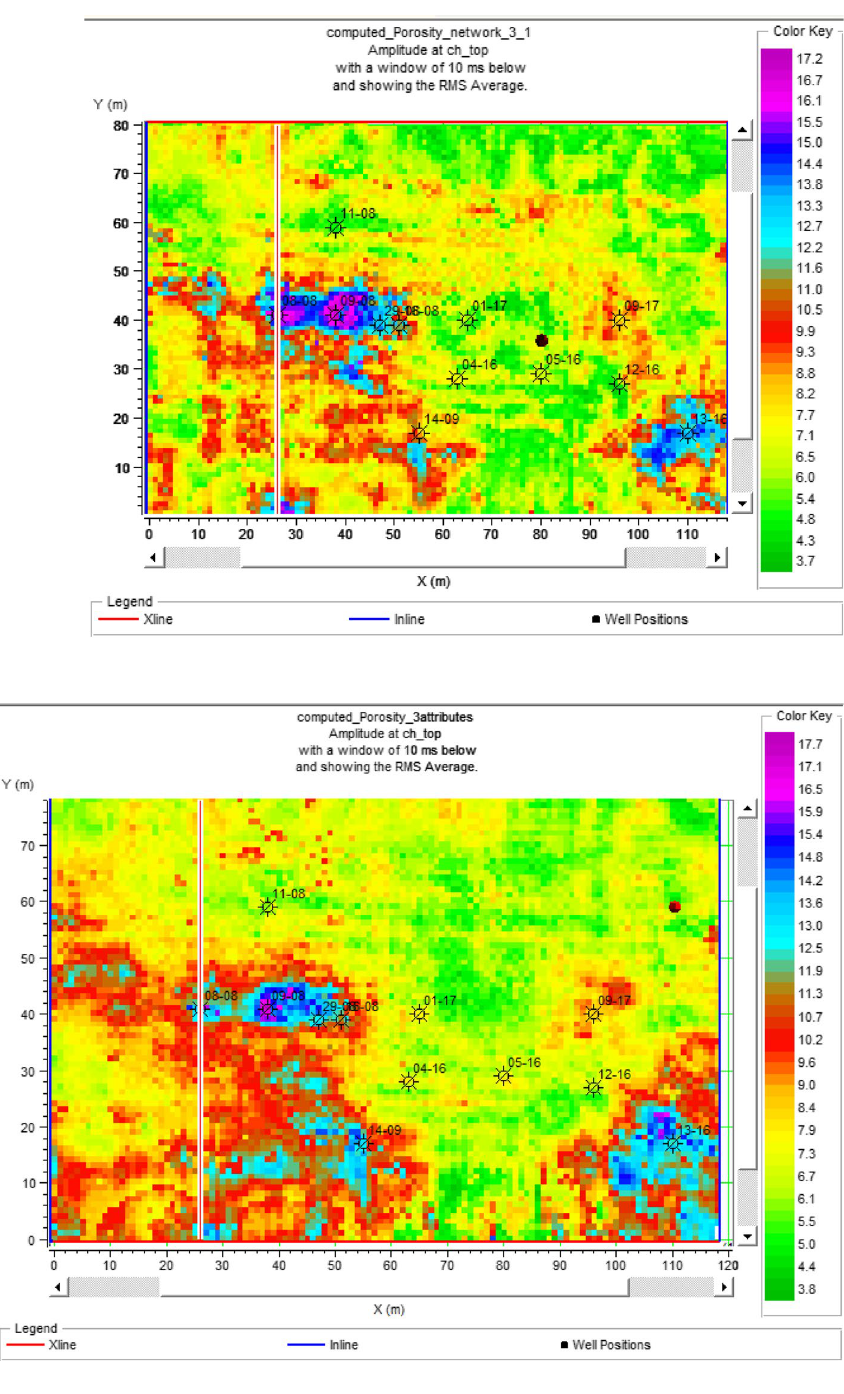
Fig. 41 2D porosity from PNN_dataset3